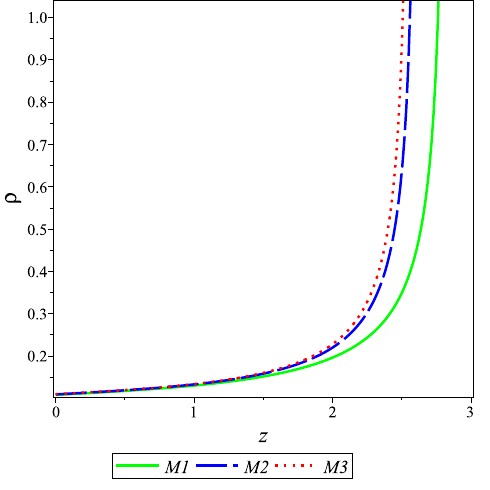
Figure 3. The energy density, ρ (40), versus redshift, z , with λ = 0.1 and ρ 0 = 1 for three observational models M1, M2, and M3. See text for details.